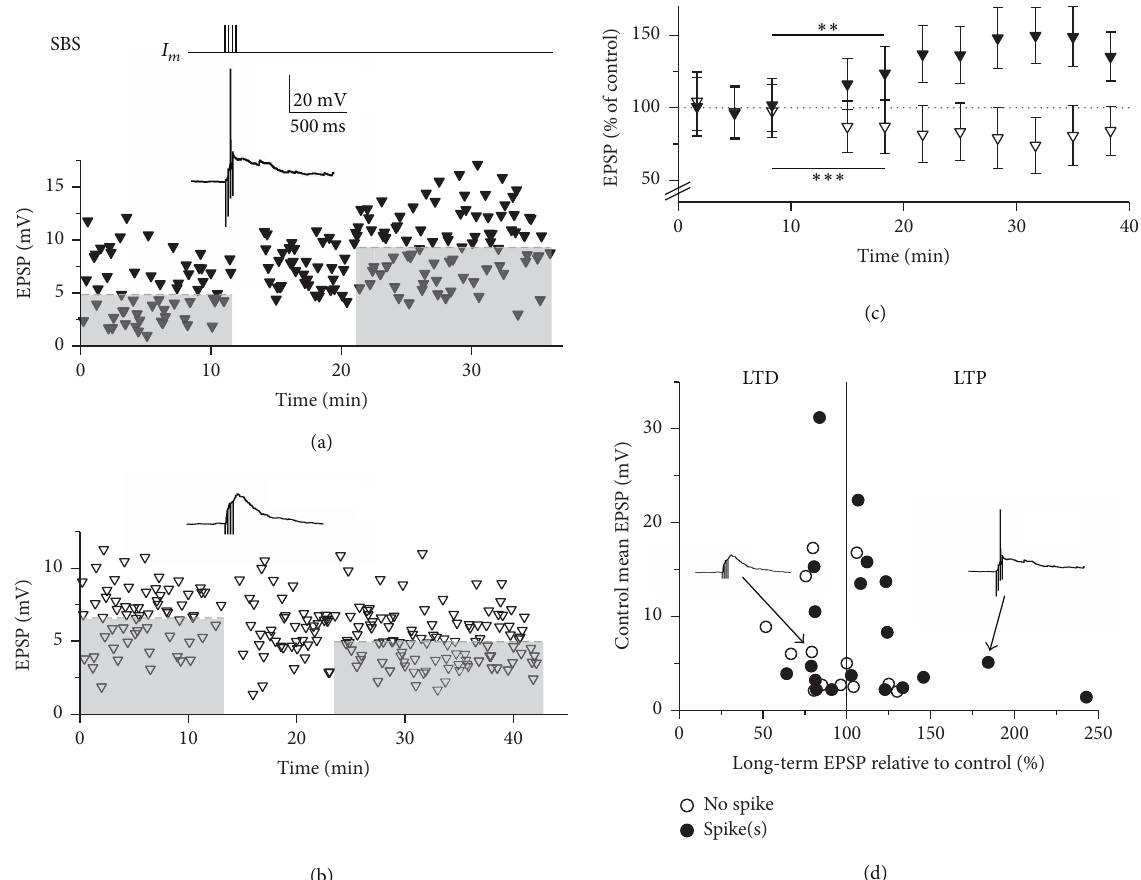
Figure 3: Single burst stimulation (SBS) results in bidirectional plasticity. Top: SBS induction protocol. (a) Individual experiment resulting in LTP. Control mean 5.1 mV; long-term mean 9.4 mV (dashed lines). Inset shows averaged response to SBS stimulation. (b) Individual experiment resulting in LTD. Control mean 6.2 mV; long-term mean 4.9 mV (dashed lines). Inset shows averaged response to SBS stimulation (same scale as in (a)). (c) Cumulative data (normalized to control) of SBS experiments with substantial LTP (solid triangles, 𝑛 = 10 ) and substantial LTD (open triangles, 𝑛 = 10 ). All data points ± SD across experiments. From the second data bins after induction onwards, bins were significantly different from the respective last data bins before induction. ∗∗ and ∗∗∗ refer to the statistical comparison between the last data point before induction and the second data point after induction for LTP (black triangles) and LTD (open triangles), respectively. (d) Cumulative display of control mean EPSP amplitudes versus the long-term change of individual experiments normalized to control of individual experiments. Open circles: experiments without action potentials (APs) during SBS; filled circles: experiments with APs during SBS. The two experiments shown in (a, b) are indicated by their SBS averages and